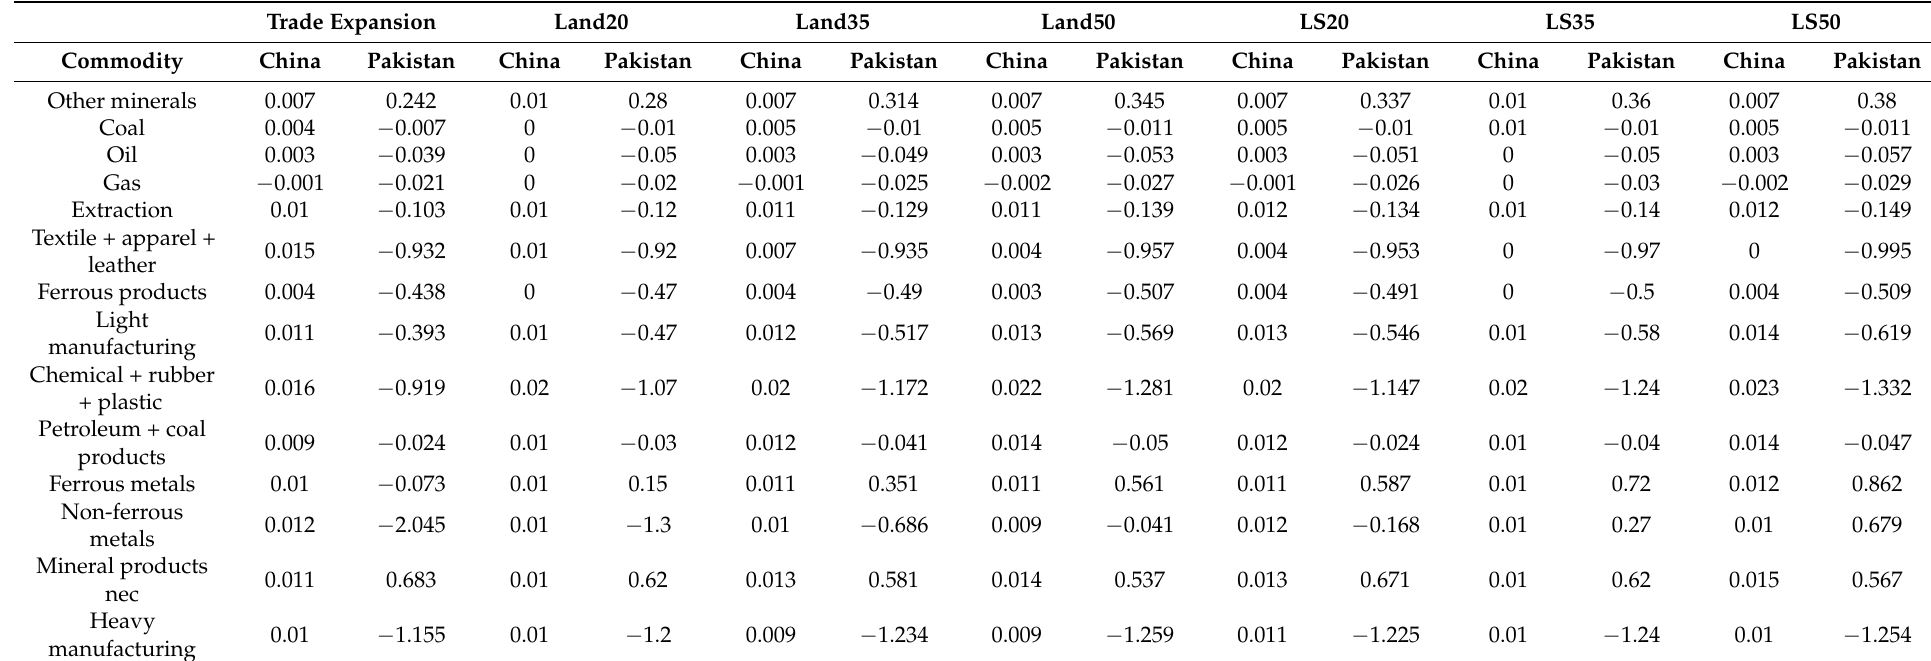
Table 5. Effects on outputs of non-agricultural sectors in Pakistan and China